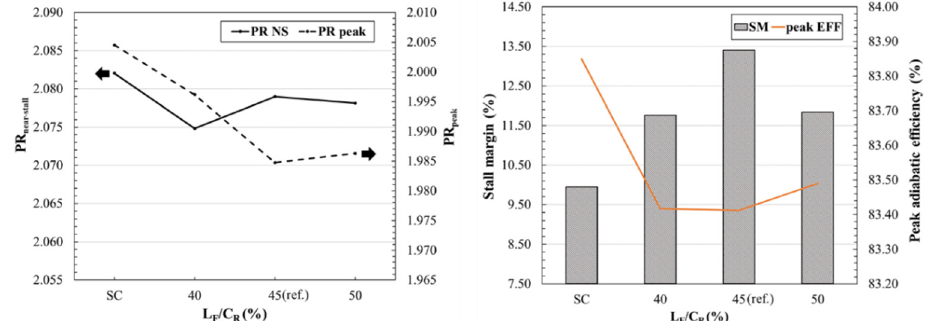
Figure 10. Effects of injection location on performance.